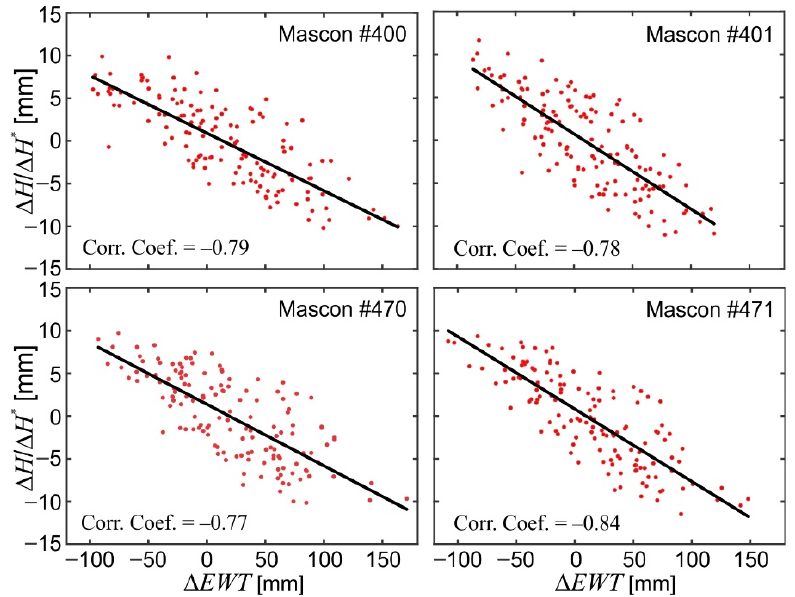
Figure 9. Correlations between temporal variations of equivalent water thickness ( Δ EWT ) and temporal variations of orthometric/normal heights ( Δ H / Δ H * ) over Poland.